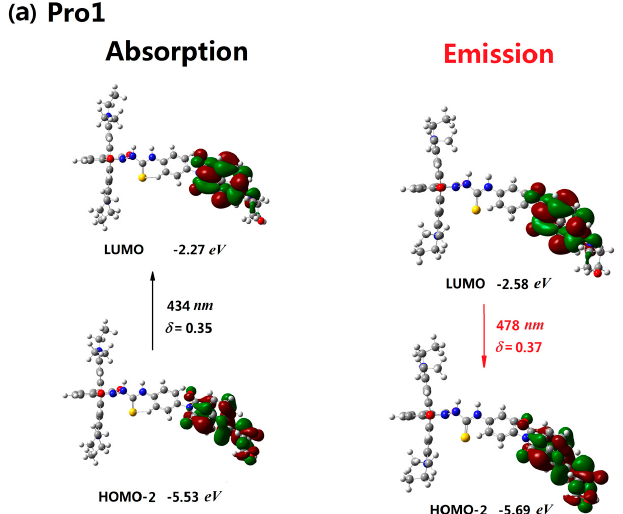
Table 3. Fluorescent emission properties, including the emission energy E ope (eV), the corresponding emission wavelength λ ope (nm), and the oscillator strength δ ope (a.u.) for Pro1, Pro1+Hg 2+ ,